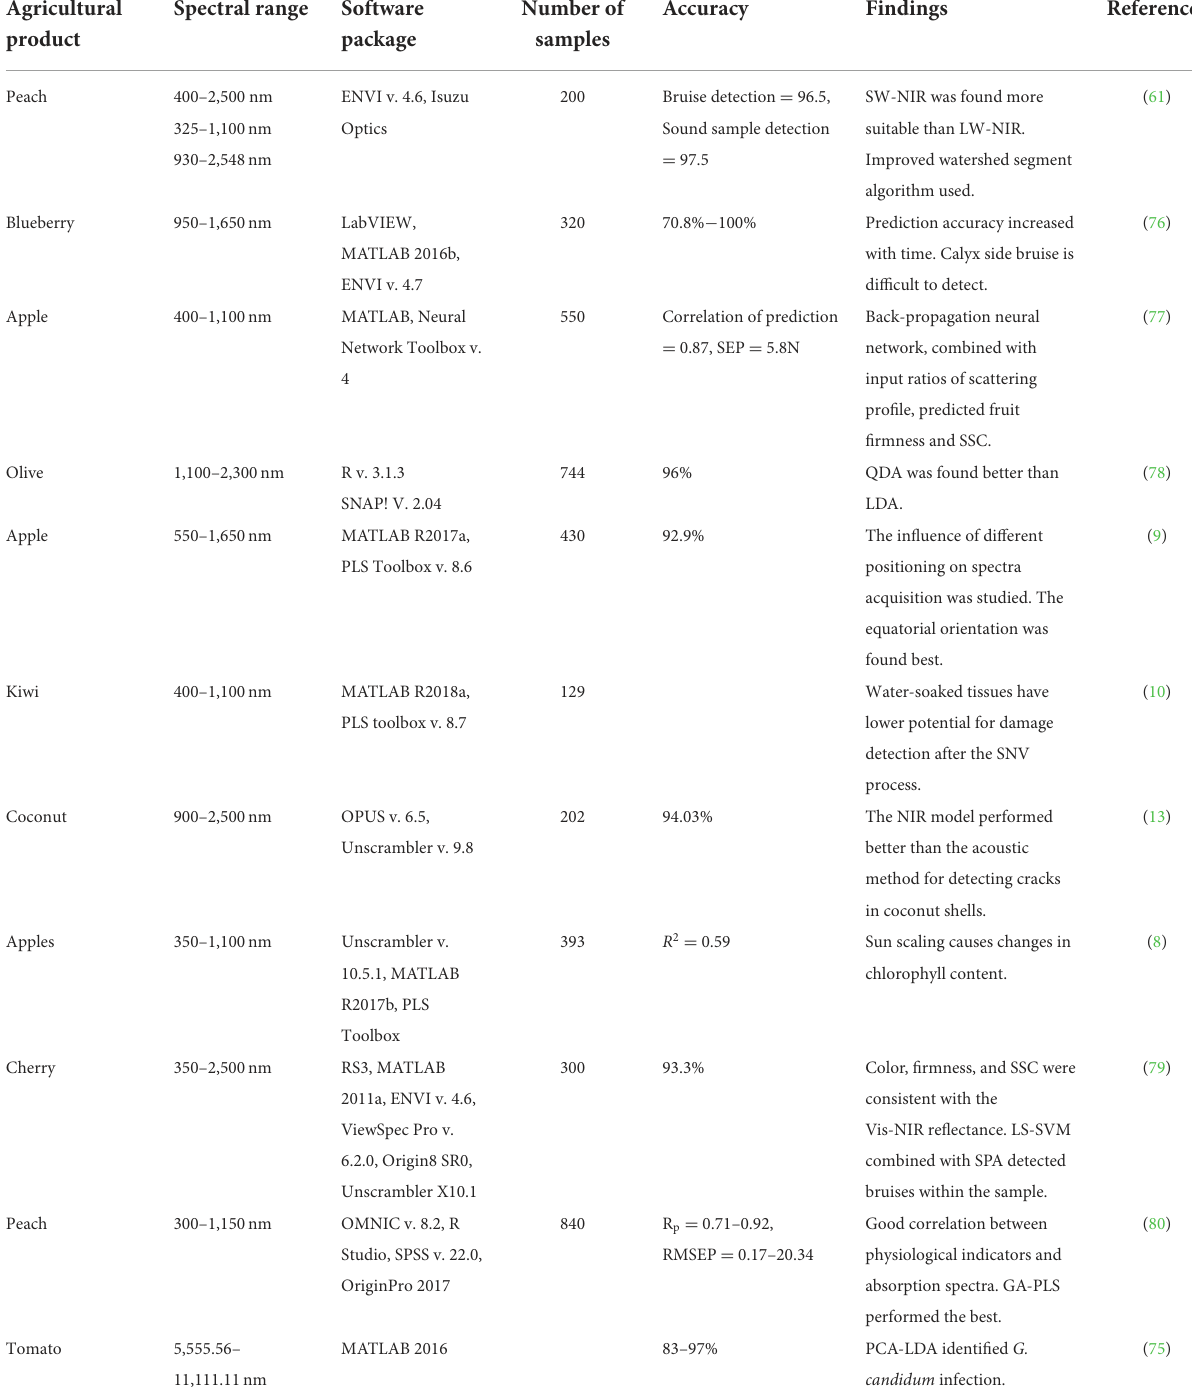
TABLE 5 Summary of NIRS applications for damage detection in agricultural